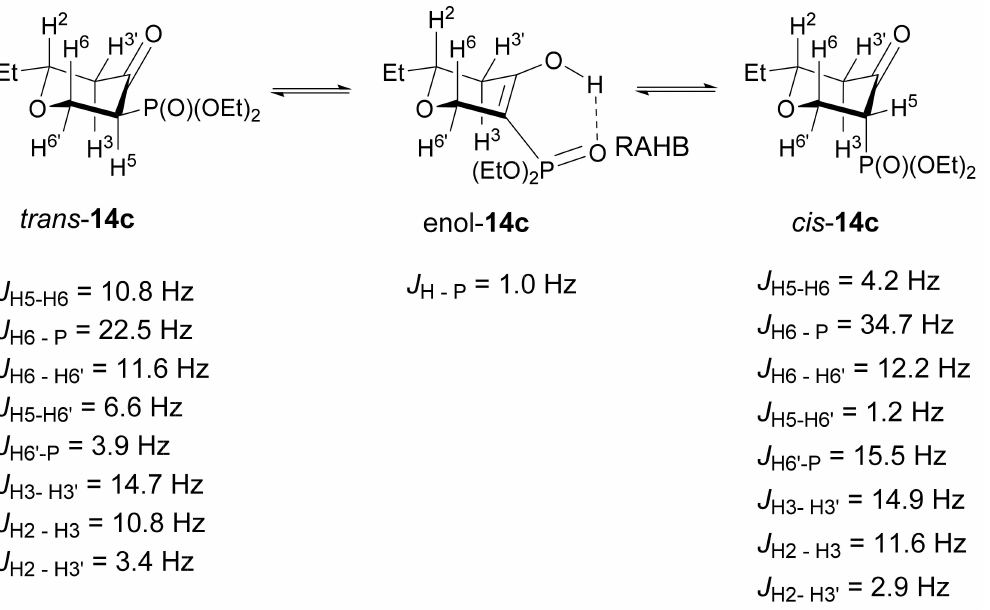
Figure 4. Characteristic coupling constants of all isomers of 5-diethoxyphosphoryl-2- phenyltetrahydropyran-4-one 14c